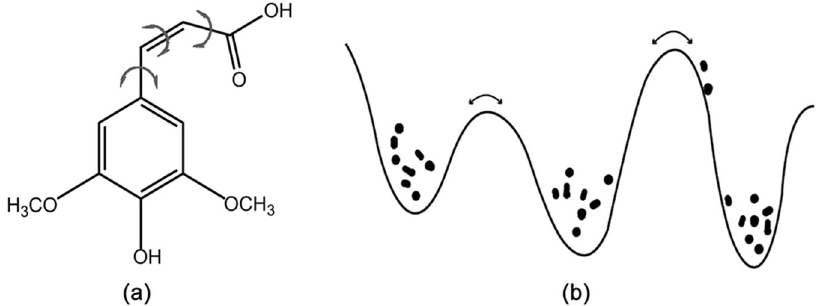
Figure 8. ( a ) The schematic structure of cis-SA molecule and the important dihedral angles are labeled with arrows. ( b ) Possible distribution of the conformational states along a simple potential energy curve. The points represent the accessible conformational states during